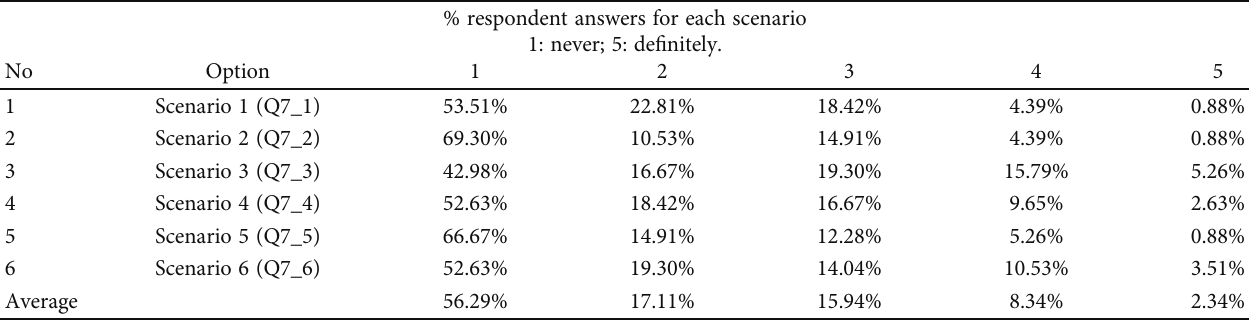
Table 3: Susceptibility scenarios: